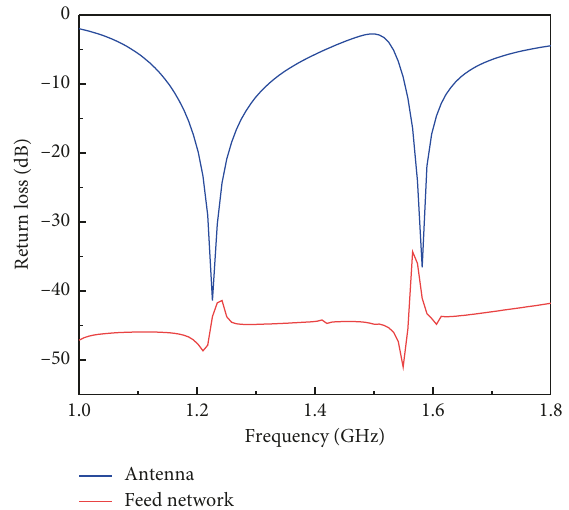
Figure 7: The simulated return loss of the antenna and the feed network.